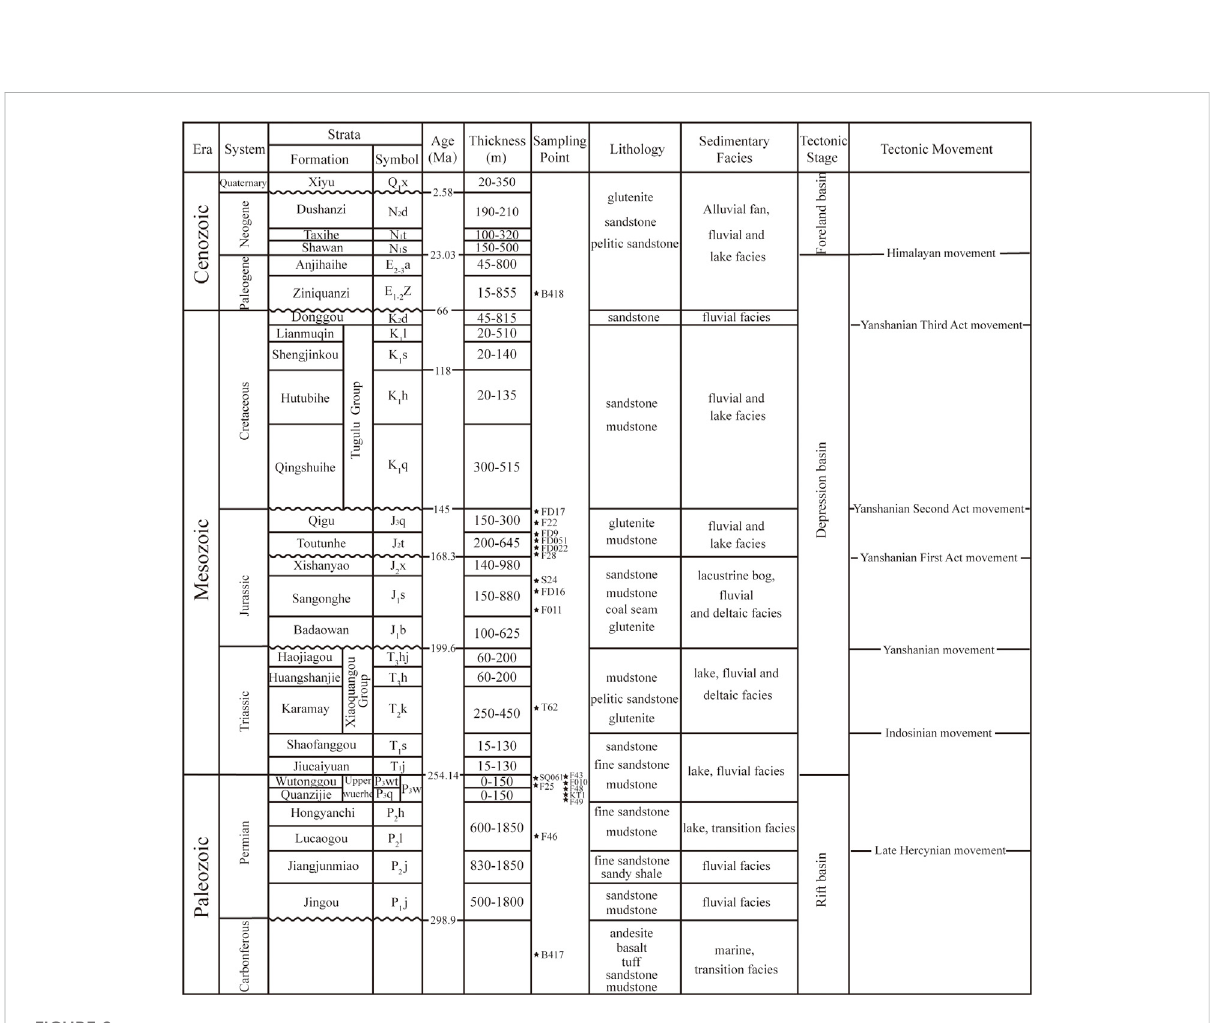
Frontiers in Earth